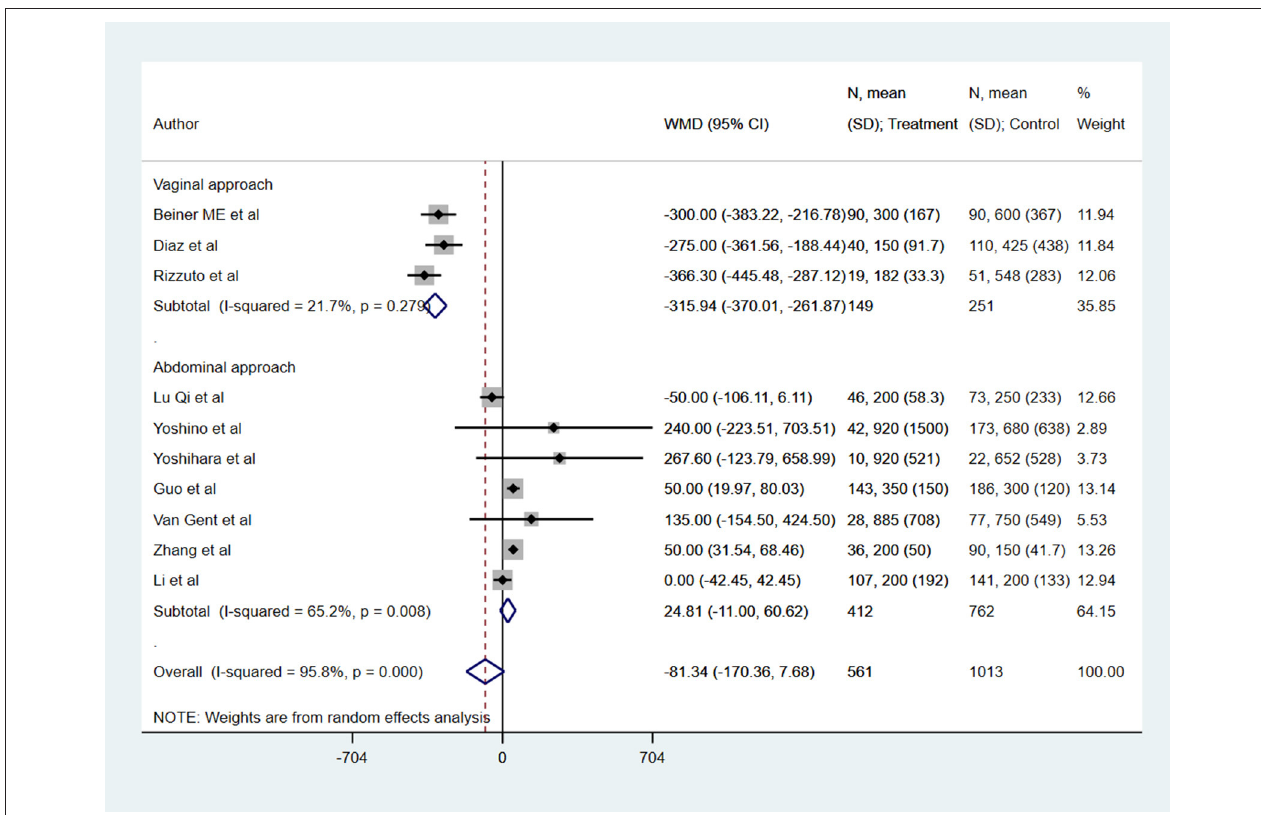
FIGURE 3 | The pooled effect size for the blood loss (in ml) is based on the comparison between radical trachelectomy and hysterectomy in patients with early-stage cervical